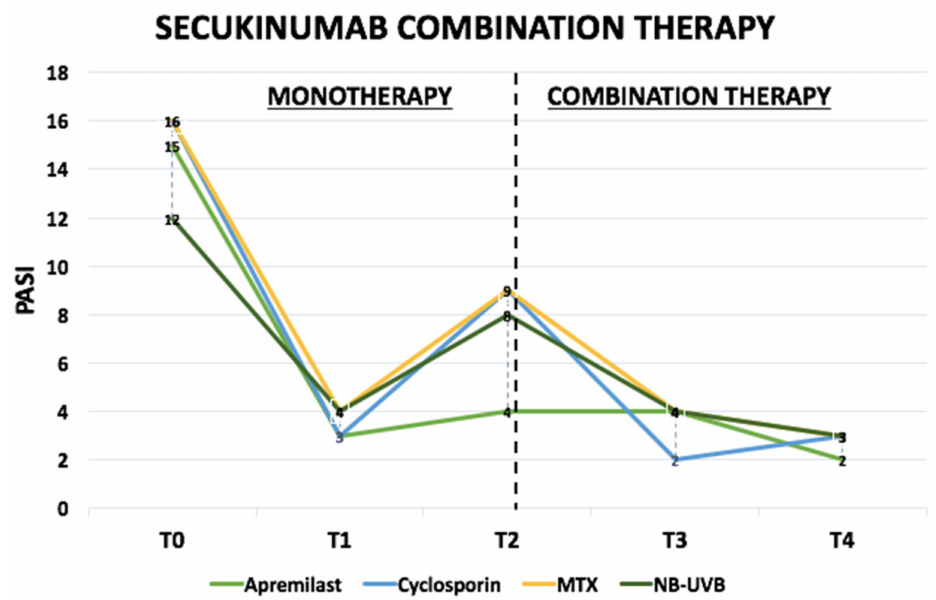
Figure 1. Therapeutic trajectories of psoriatic patients undergoing secukinumab in combination with an another systemic anti-psoriatic drug. MTX: Methotrexate, NB-UVB: Narrow-band UVB, PASI: Psoriasis Area Severity Index. T0: starting secukinumab induction phase, T1: week 16,